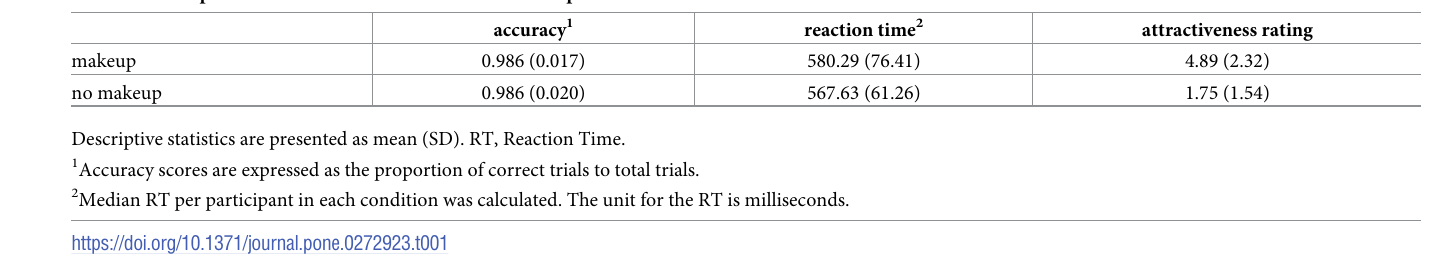
Table 1. Descriptive statistics for behavioral measures in Experiment